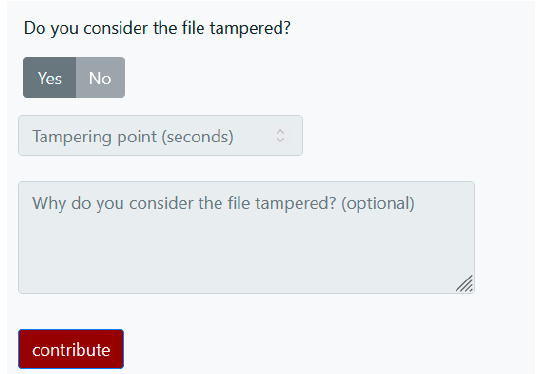
Figure 4. In Contribute mode, users can browse files from the database along with their analysis visualizations, and annotate them concerning the detection of audio